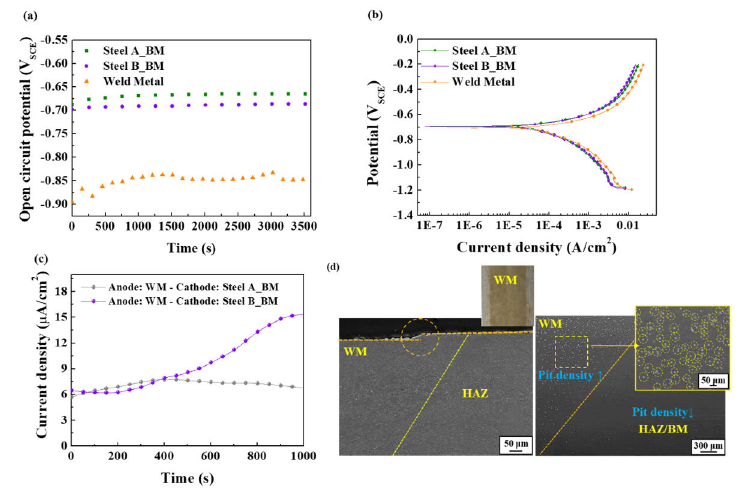
Figure 4. Measurements of ( a ) OCP, ( b ) PD polarization, and ( c ) Galvanic current; ( d ) Metallographic observation of weld metal in Steel A after an immersion test.